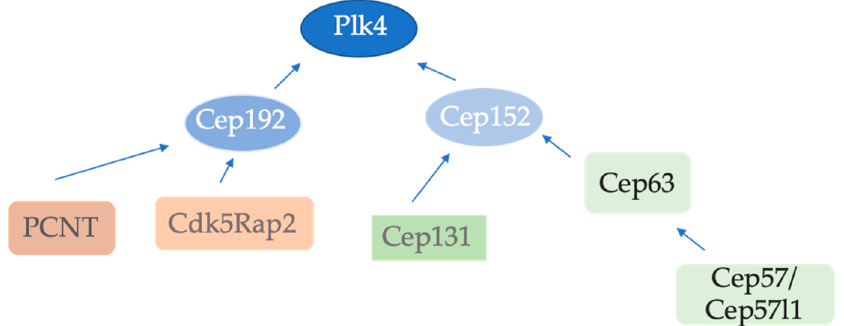
Figure 2. Recruitment of centriole duplication proteins to the centrosome. Plk4 is recruited by both Cep152 and Cep192. PCNT and Cdk5Rap2 recruit Cep152 whereas Cep152 recruitment to the centrosome is mediated by Cep131 and the Cep63/Cep57(Cep57l1) complex. Cep192 is recruited to mitotic centrosomes by PCNT and Cdk5Rap2. Table 1. Mammalian proteins and their orthologs involved in the early steps of centriole duplication.